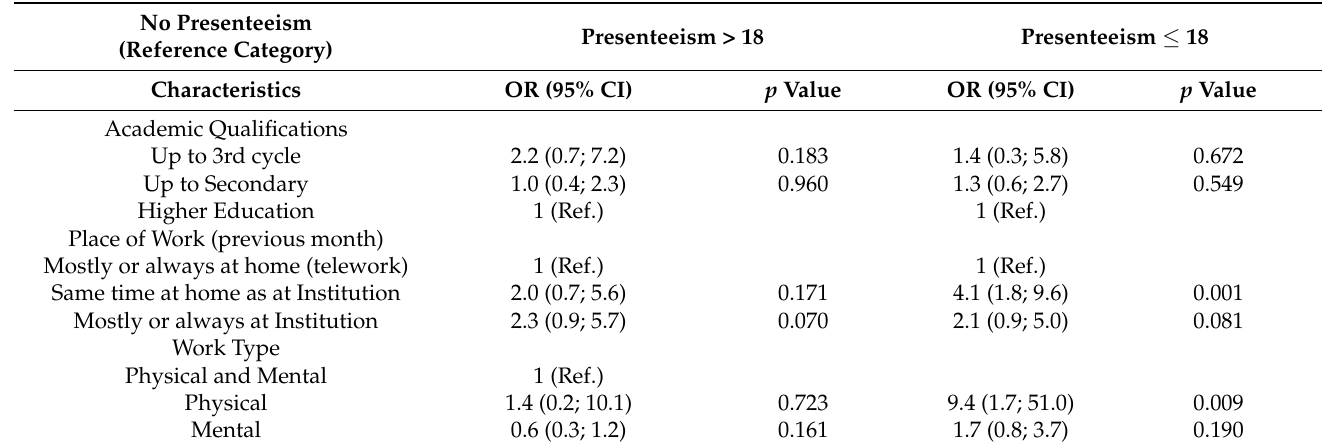
Table 2. Multinomial logistic regression analysis of socio-demographic and work factors associated with presenteeism.